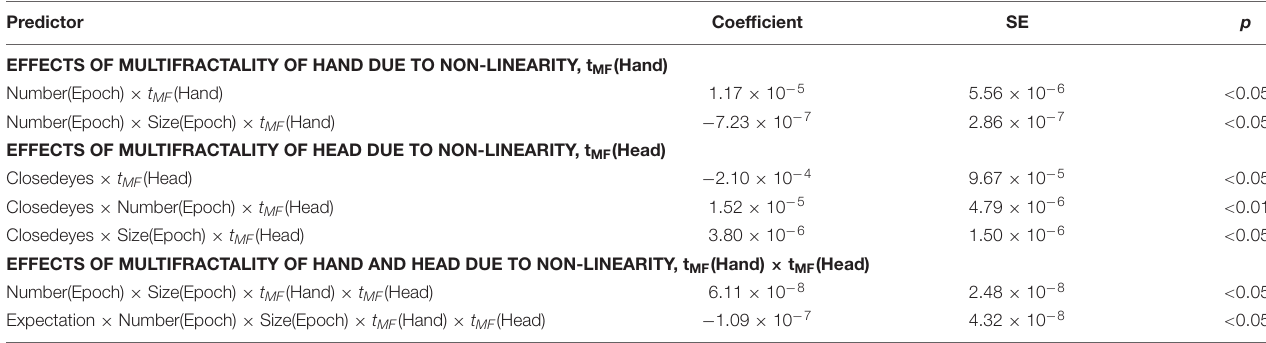
FIGURE 6 | Lateral hand position over time for 50 s in the second half of the task with eyes open. Solid lines show the lateral position of the hand over time in the second half of the task for two participants both with their eyes open. Top panel shows movement series for a participant who had expected that they might have to close their eyes. Bottom panel shows movement series for a participant who had no expectation of having to close their eyes. Dashed horizontal lines schematize the average lateral position of manual contacts from which aiming variability SD(Aim) was calculated. TABLE 1 | Significant effects from regression modeling of manual-aiming variability